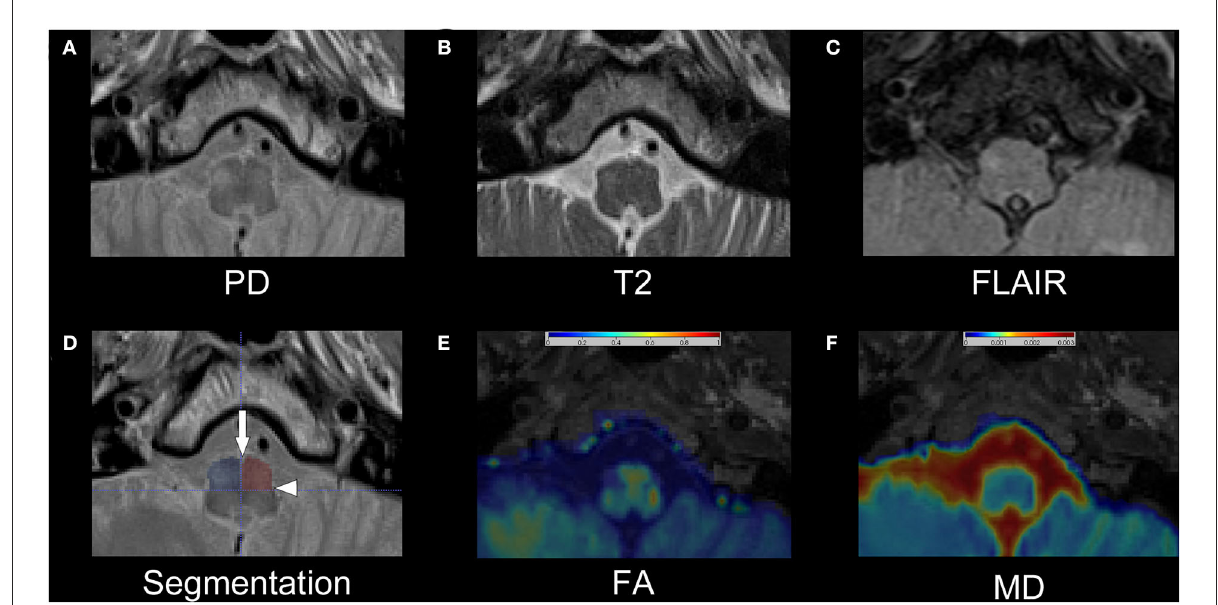
FIGURE1 Exemplary dataset of patient number 13. The upper row shows the cropped PD-w (A) , T2-w (B) , and FLAIR (C) images that were used for the rater-based analysis. The segmentation of the anterior quadrants of the medulla oblongata is shown as semitransparent overlay on the PD-w image in (D) with an additional indication of the anterior median fissure (arrow) and the posterolateral sulcus (arrowhead). While the left ION is hardly visible, especially in the T2-w image and FLAIR, the right ION is hyperintense and possibly enlarged, indicating HOD. Images (E) and (F) show the corresponding FA and MD maps as interpolated and color-coded, semitransparent overlay on a T1-w image. In comparison with the left ION, a decrease in FA and an increase in MD are recognizable in the right ION. PD, proton-density; w, weighted; FLAIR, fluid-attenuated inversion recovery; ION, inferior olivary nucleus; HOD, hypertrophic olivary degeneration; FA, fractional anisotropy; MD, mean diffusivity.